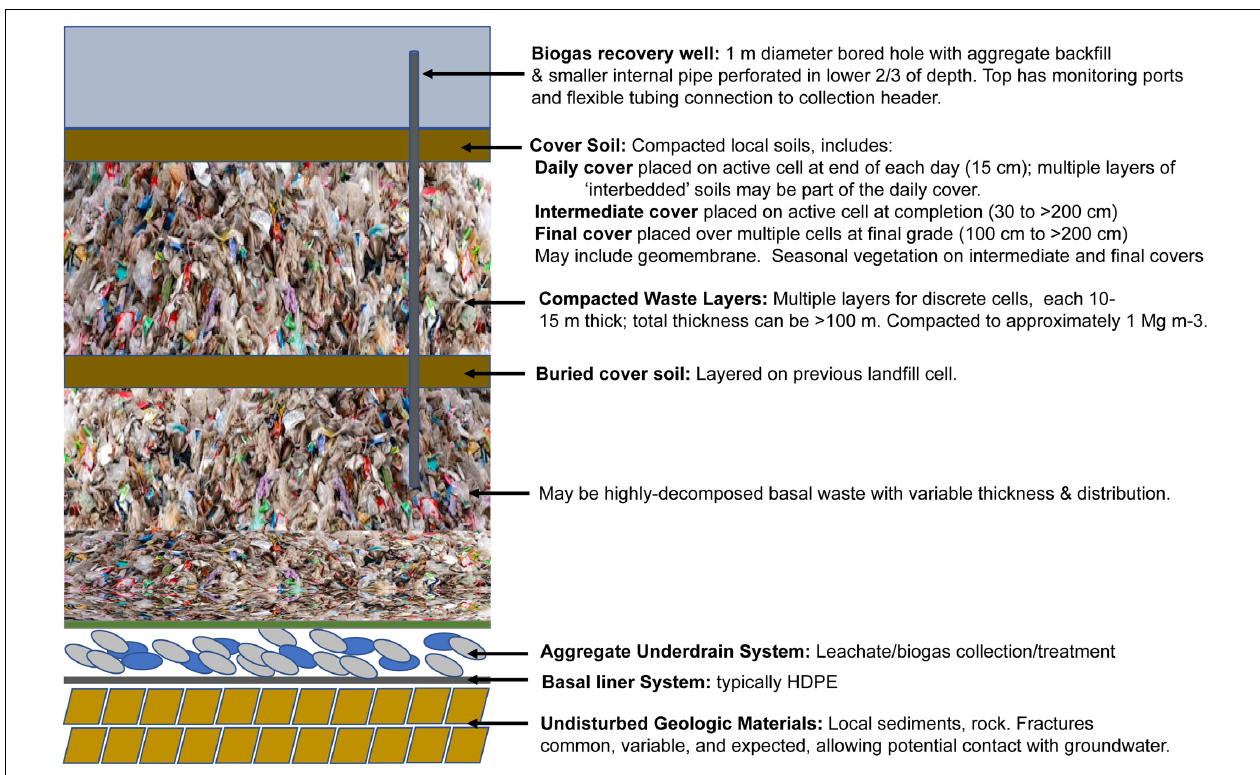
FIGURE 2 | Typical construction for United States landfills, in